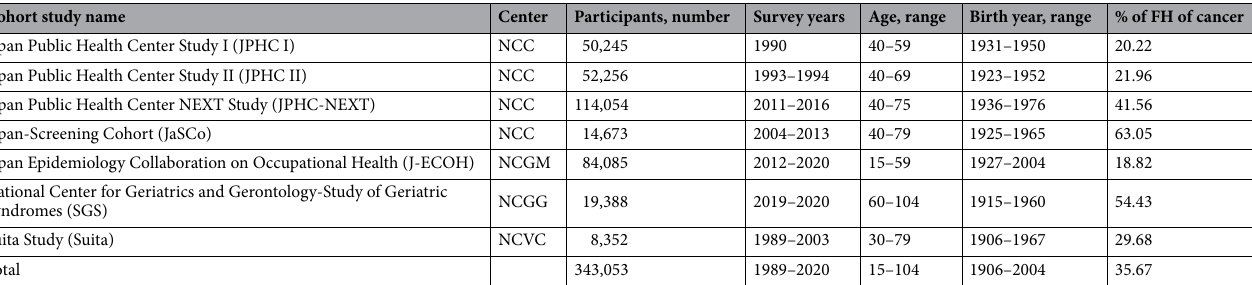
Table 1. Overview of participating cohorts of the Japanese Six National Centers (6NC) consortium. National Cancer Center (NCC), National Cancer for Global Health and Medicine (NCGM), and National Center for Geriatrics and Gerontology (NCGG), National Cerebral and Cardiovascular Center (NCVC); Age refers to age at baseline.